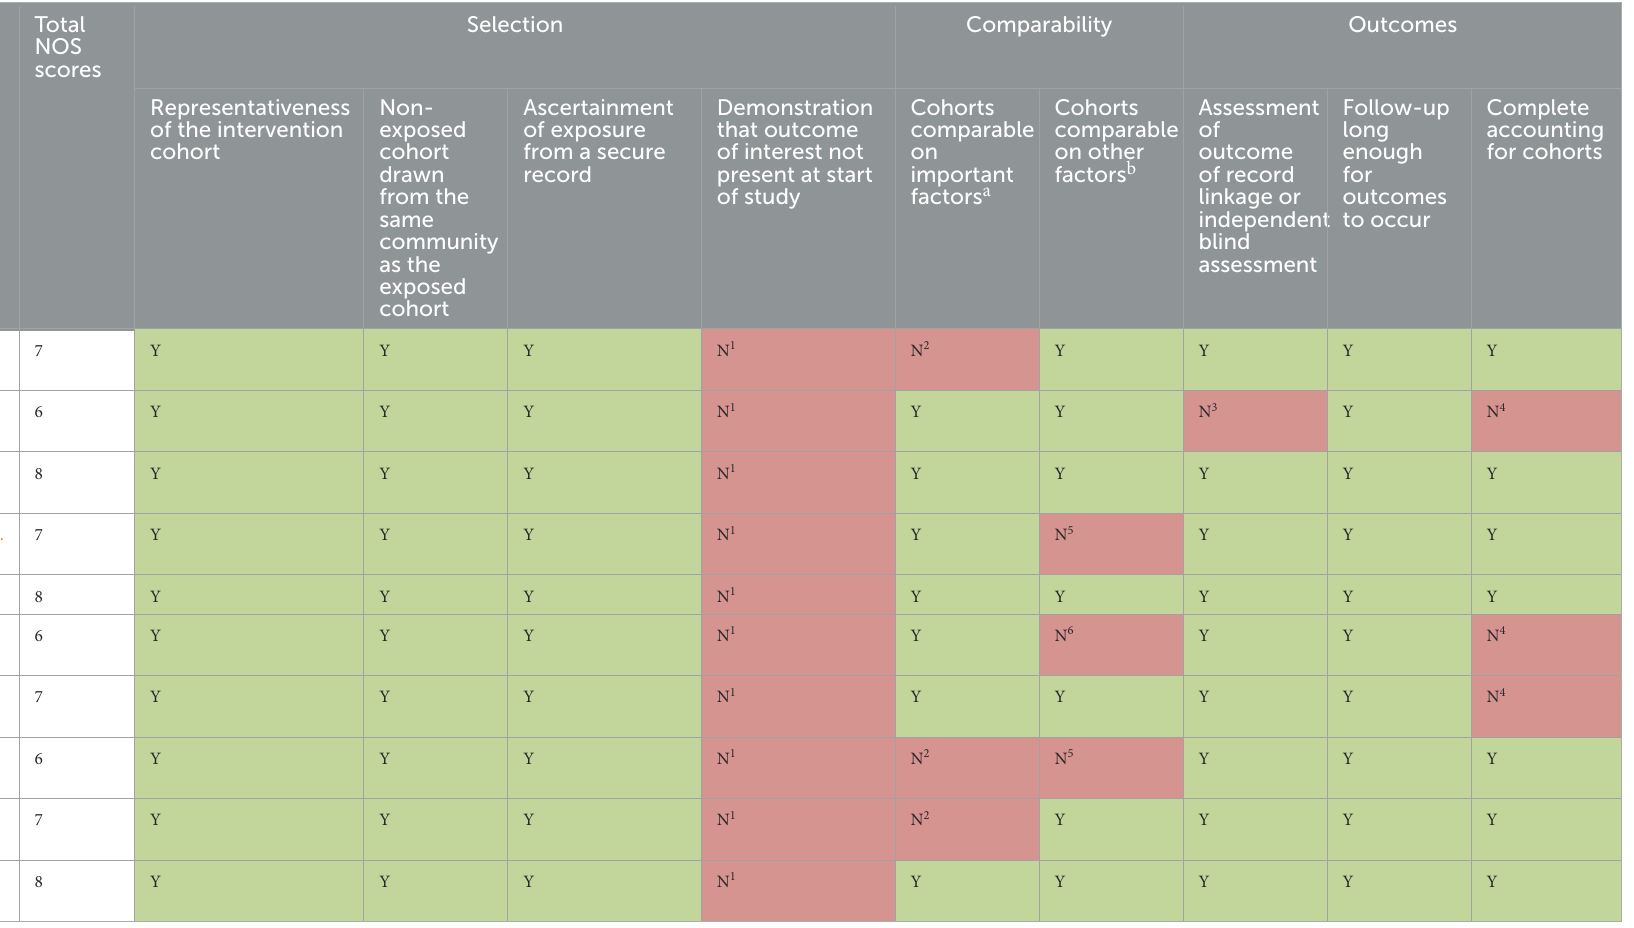
TABLE 2 Risk of bias of cohort